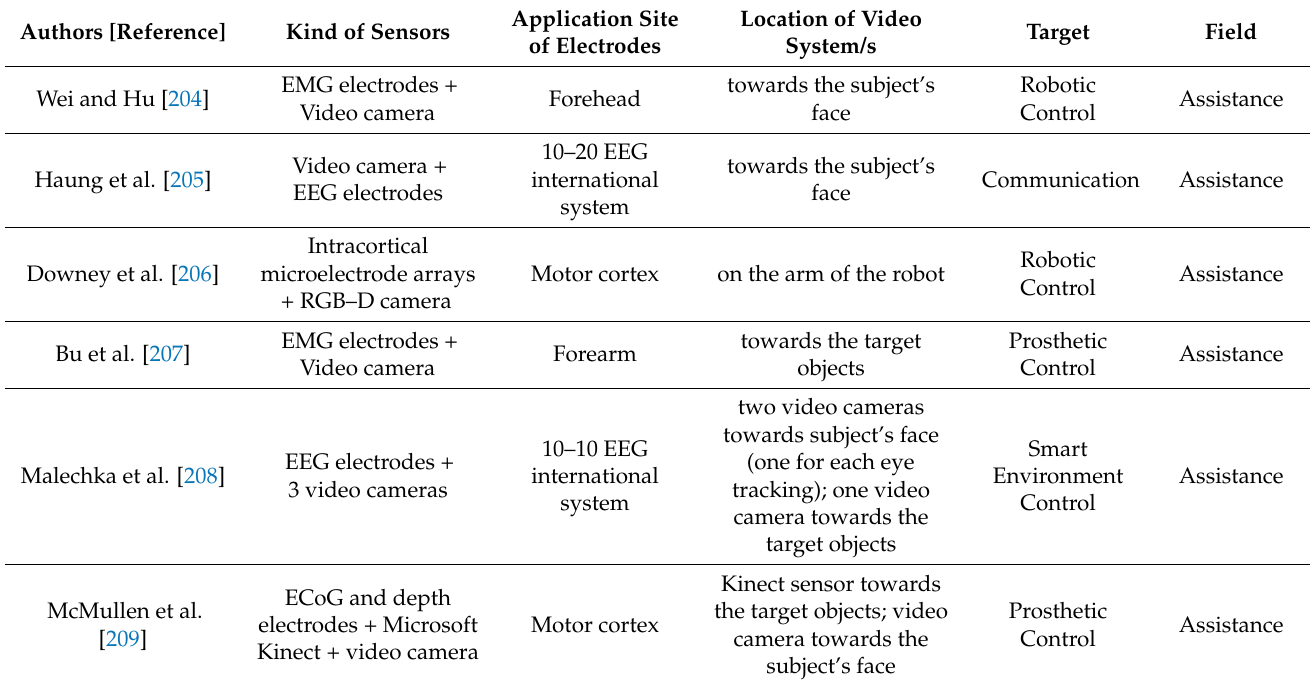
Table 13 outlines the hybrid controls for HMIs based on biopotentials and image-based systems included in the current survey. Table 13. Hybrid controls for HMIs based on Biopotentials and Image-based